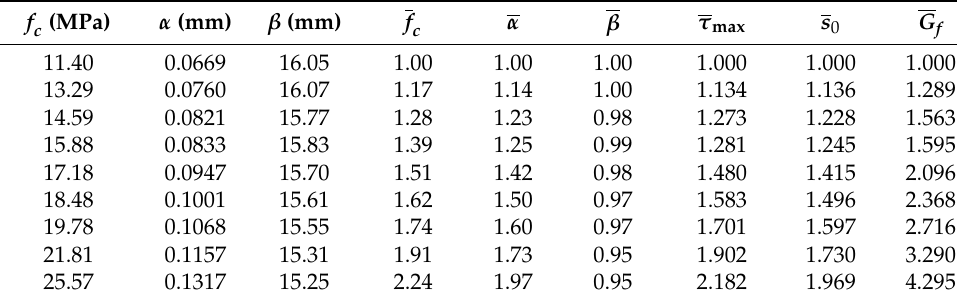
Table 5. Calculation results under different brick strength.